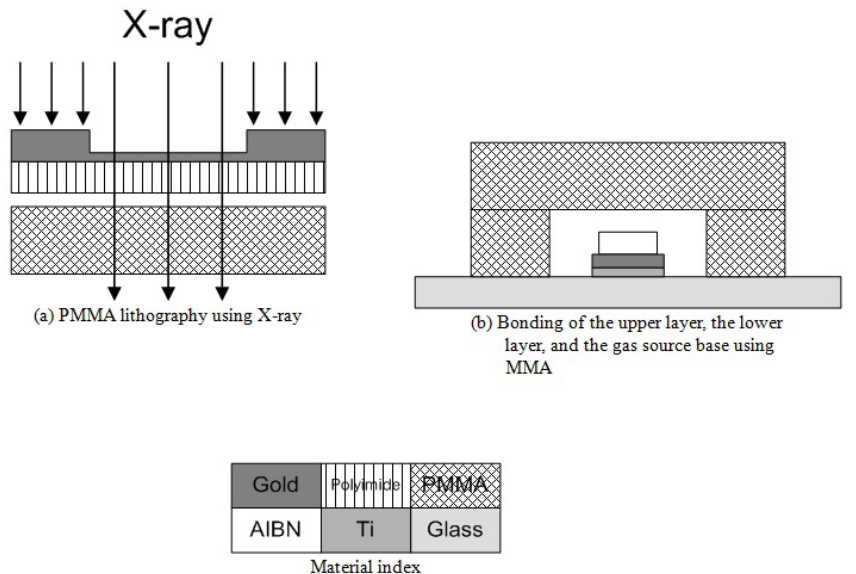
Figure 6. The fabrication process flow of the PMMA gathering